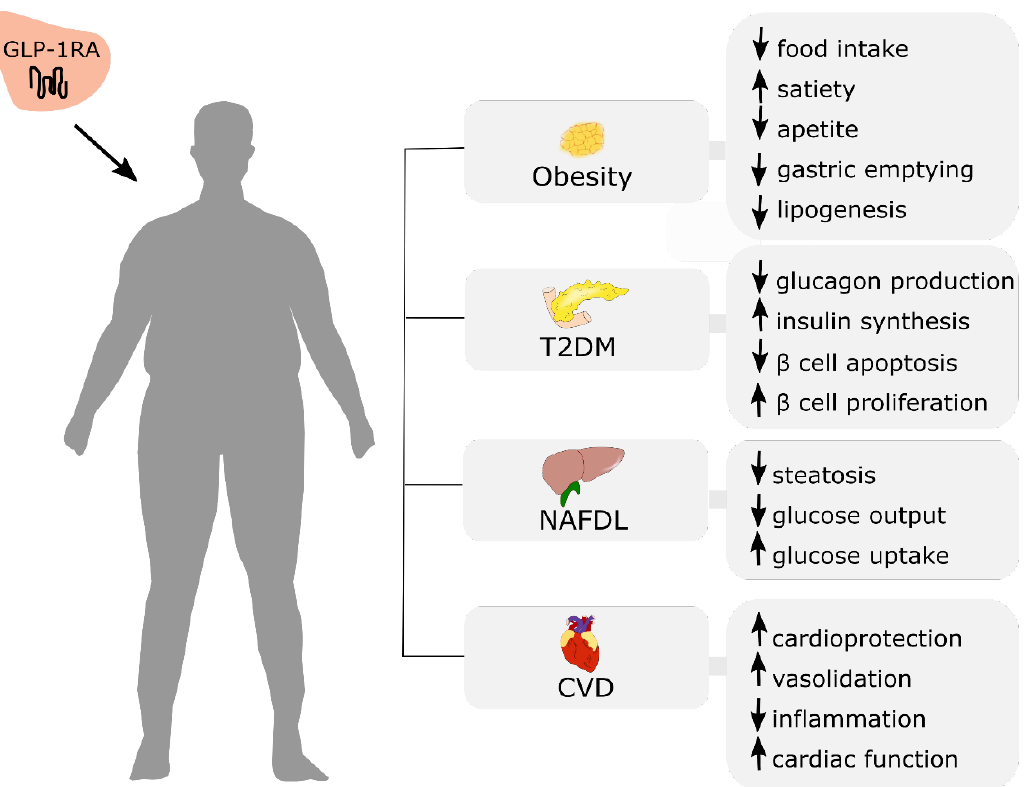
Figure 4. Potential therapeutic effects of GLP-1RA administration in obese patients with co-existing cardiometabolic disorders. T2DM: type 2 diabetes mellitus; NAFLD: non-alcoholic fatty liver disease; CVD: cardiovascular disease. ↑ : increase; ↓ : decrease.